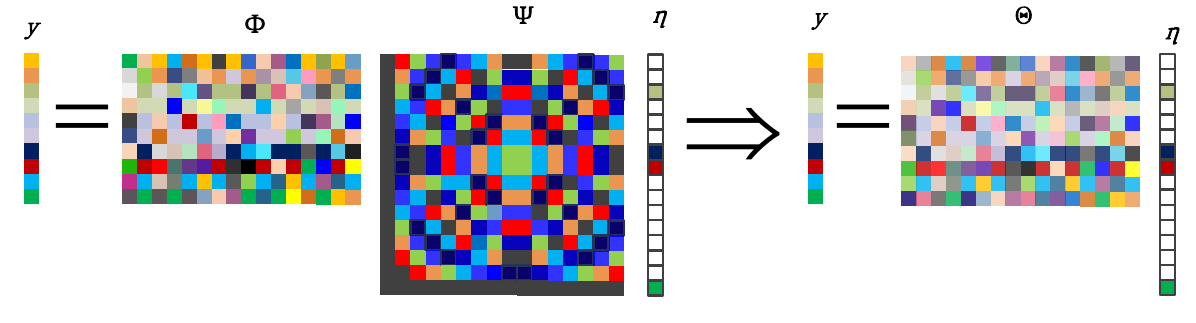
Figure 3. The framework of compressive sensing